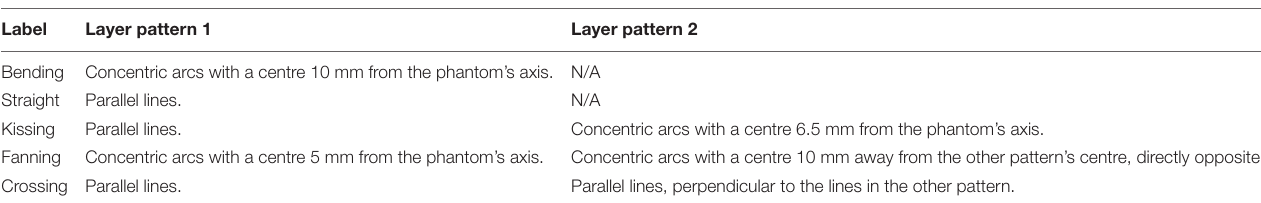
TE/TR = 37/2,500 ms, FOV = 200 × 200 mm 2 , 0.7 mm isotropic in-plane resolution, and one 3 mm axial slice per